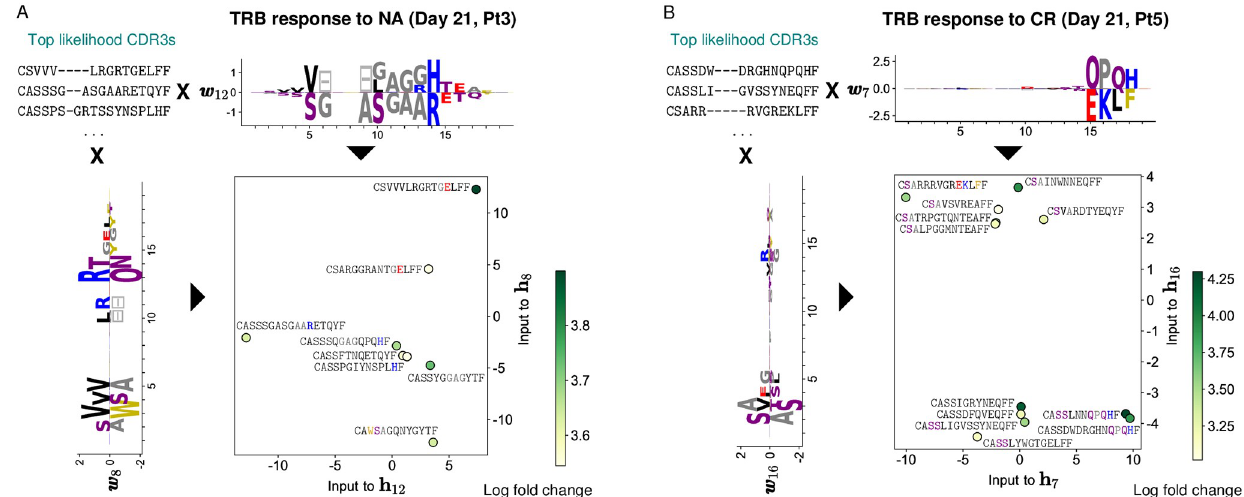
Fig 5. RBM-based dimensionality reduction of TRB response. A: A lower-dimensional representation of RBM predicted TRB sequences of Pt3 responding to the NA antigen 21 days post-stimulation (same model as in Figs 1 and 2). We rank CDR3 sequences by likelihood and look at the top ones (8 clones). We select 2 sets of RBM weights displaying well-defined patterns of amino acid usage at the beginning and at the end of the CDR3 (respectively w 8 and w 12 ). The projection of top-likelihood clones onto these weights define the inputs to the corresponding hidden units ( h 8 and h 12 ) in two dimensions. Depending on sequence patterns (see colored amino acids), responding clones have either a positive or negative projection onto the selected weights and end up occupying different portions of the space of inputs to hidden units. The color code (log base 10 of fold change) highlights that high model likelihood reflects high fold change. B: Same data representation by the RBM as in A, with the 12 top-likelihood clones for the Pt5 CR assay.